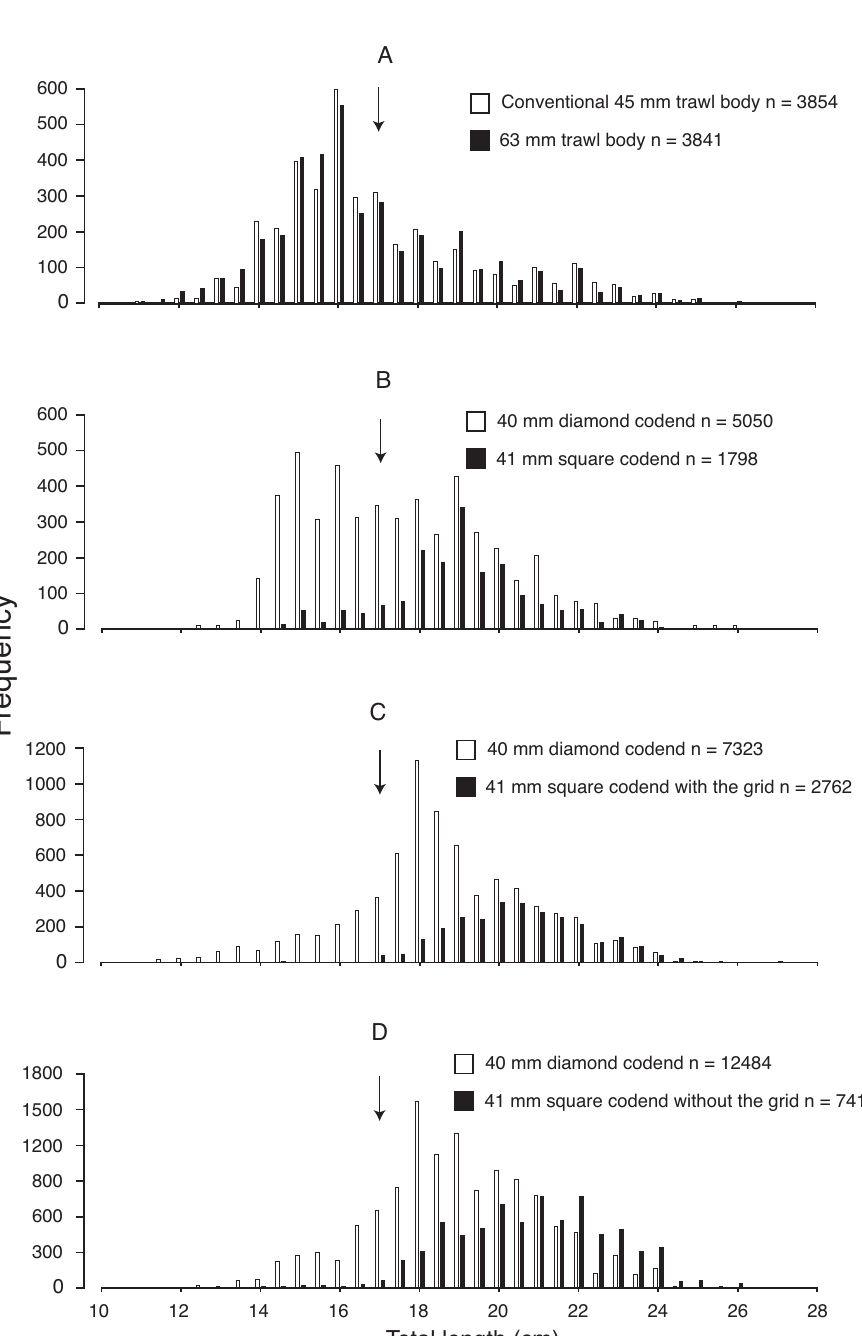
F IG . 5. – Total length-frequency distributions of red spot whiting retained in the conventional gear and the A) 63 mm trawl body tested in experiment 1, B) 41 mm square codend tested in experiment 2 and the 41 mm square codend tested in experiment 3, C) with and, D) without the grid attached. The arrows mark the minimum commercial size (17 cm Experiment 3: effects of a separating grid in the extension